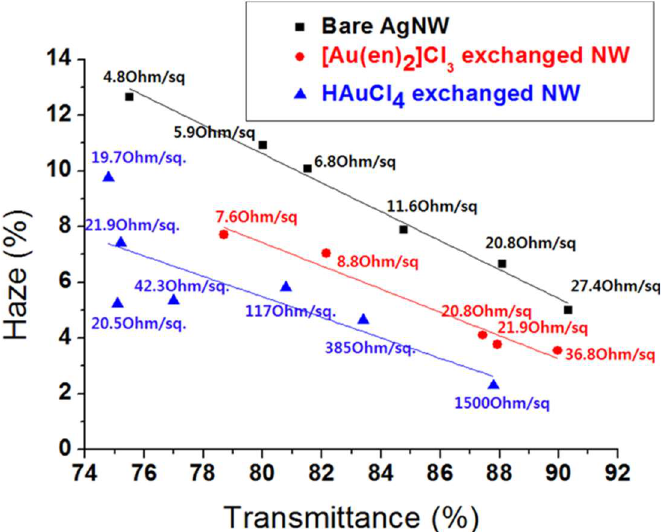
Figure 9. Comparison of haze and transmittance for transparent films fabricated with bare Ag nanowires, Au-coated Ag nanowires made using HAuCl 4 exchange, and Au-coated Ag nanowires made using [Au(en) 2 ]Cl 3 exchange and NH 3 treatment. The sheet resistance for each sample is also stated. Reprinted from [77], with permission from American Chemical Society, 2014.